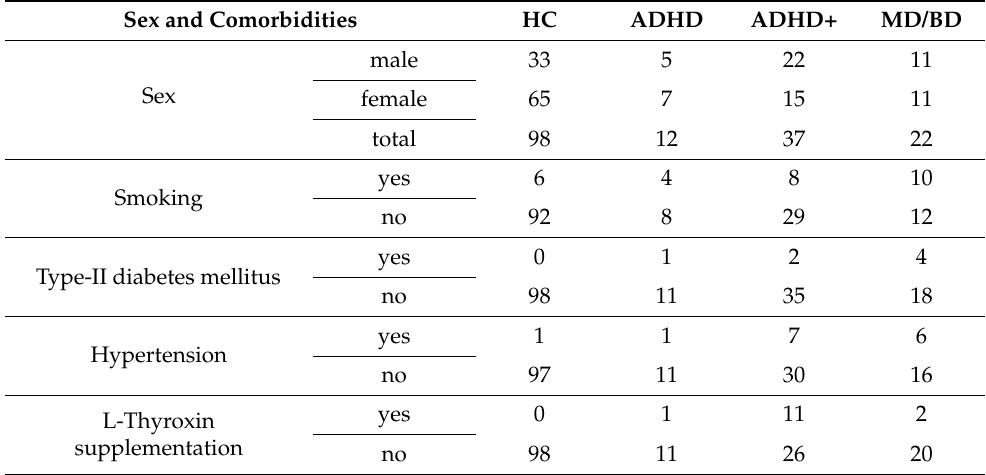
Table 2. Comorbidities of healthy controls (HC) and patients with ADHD, ADHD+ (ADHD plus MD/BD or MD/BD.